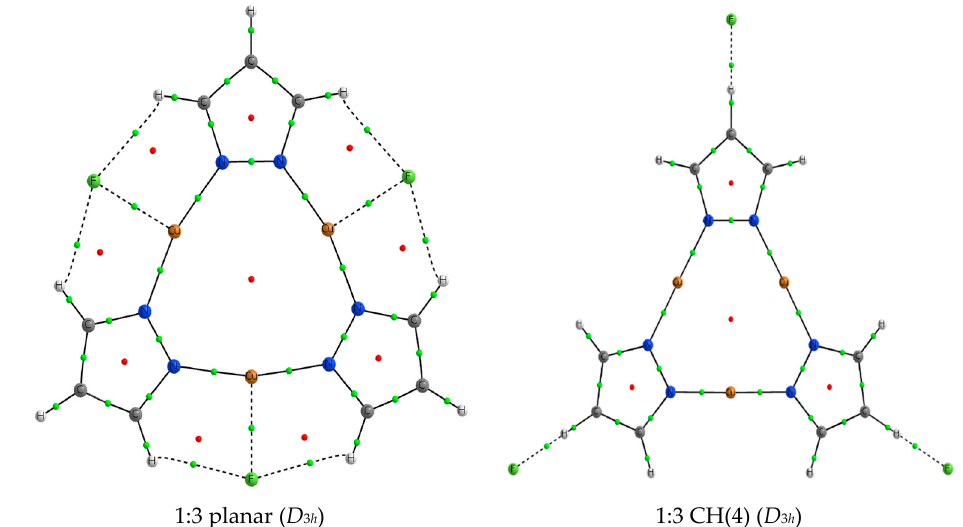
Figure 7. Molecular graph of the two minima located for the 1:3 (Pz-Au) 3 :F − . The symmetry of each complex is indicated. Small green and red dots indicate the position of the bond and ring critical points, respectively.